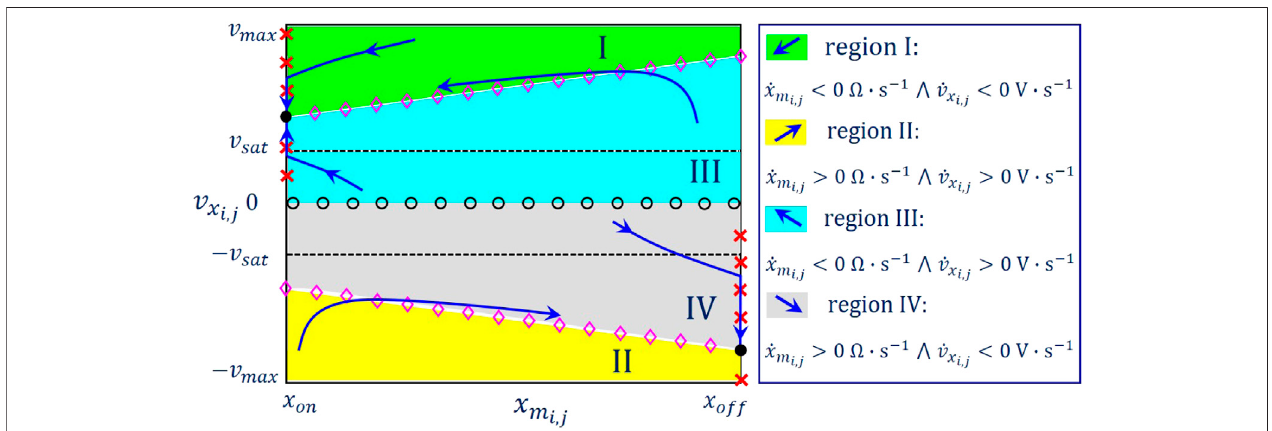
(cid:1) 0A, if a > G + x − 1 0 , 0 x on . The capacitor voltage range under display is i , j